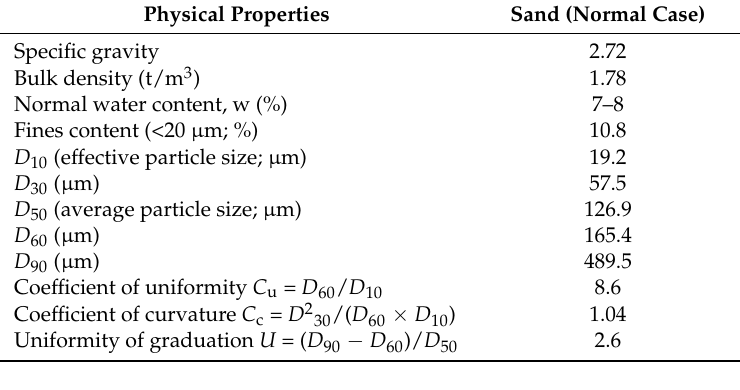
Table 1. Physical properties of the utilized alluvial sand in backfill.